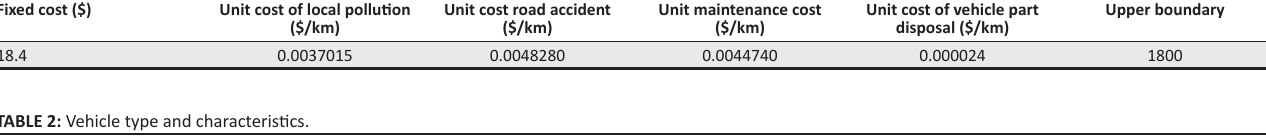
TABLE 1: Fixed cost, social cost and upper boundary. Fixed cost ($)